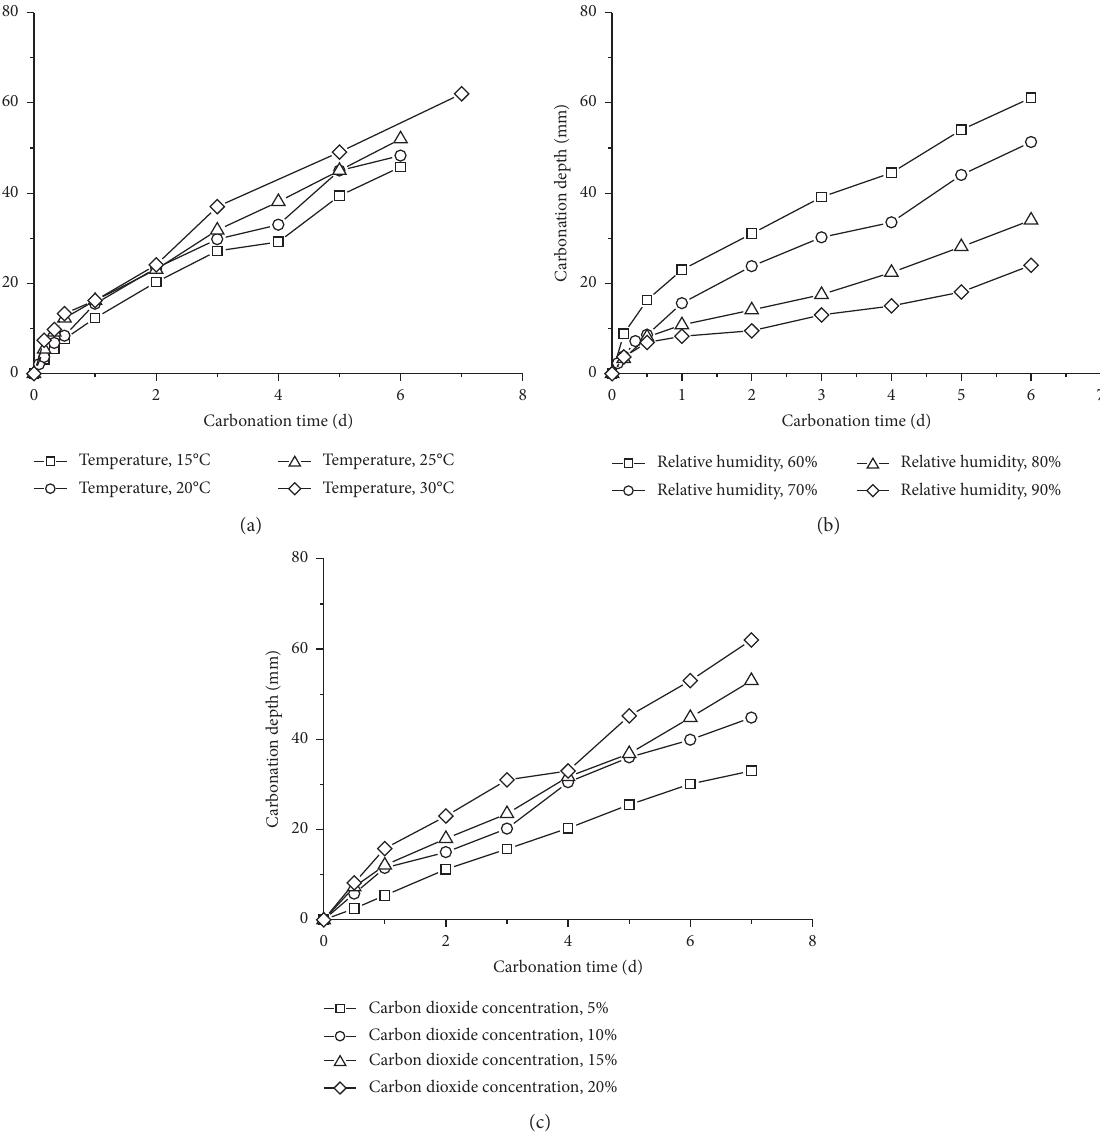
Figure 6: Evolution of carbonation depth with time of the lime-stabilized expansive soil, effect of (a) temperature, (b) relative humidity, and (c) carbon dioxide